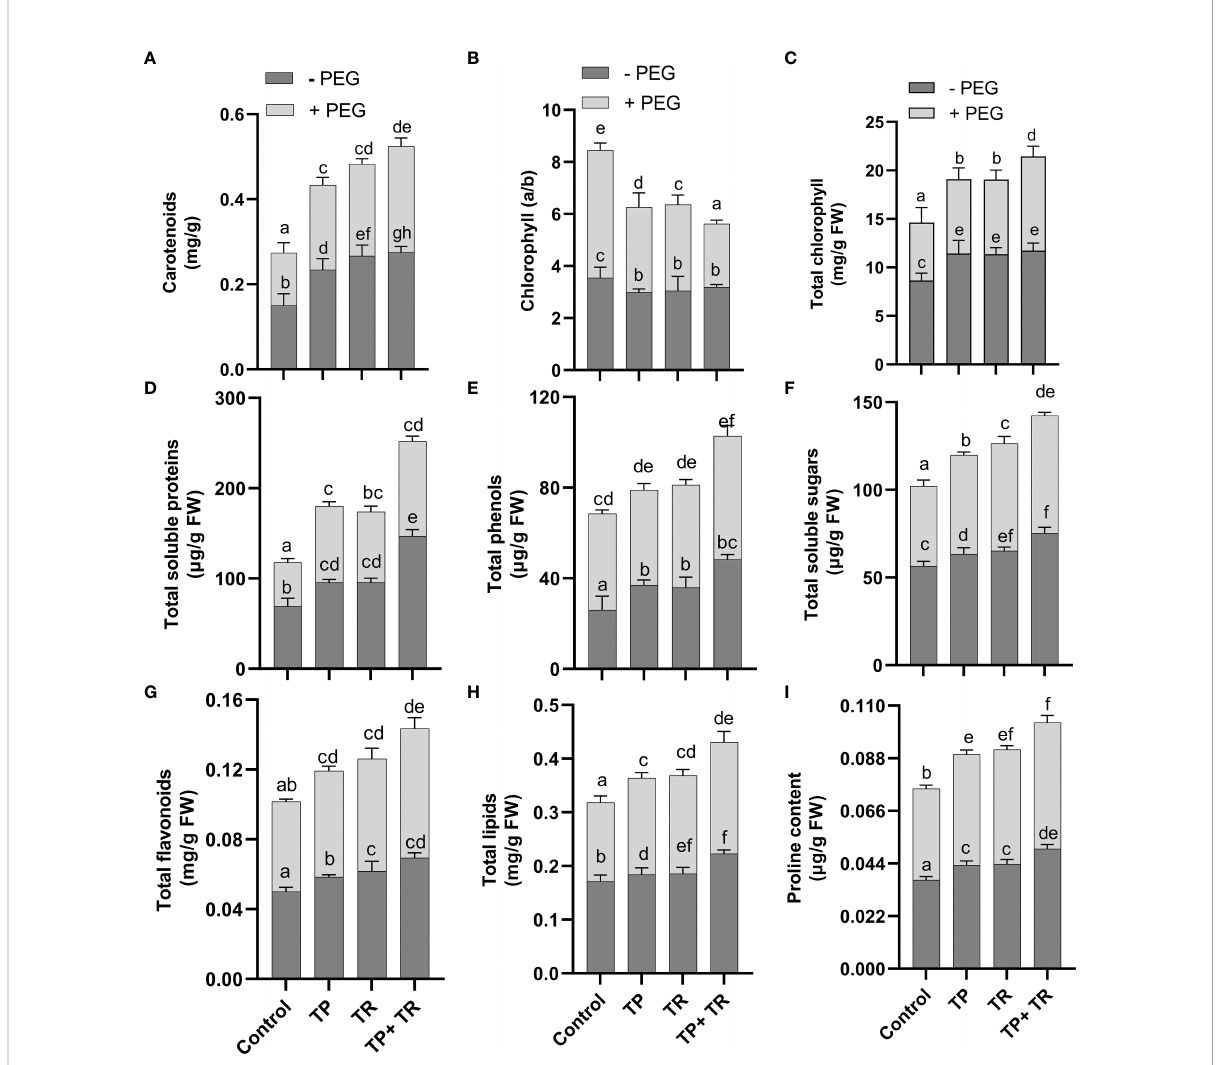
FIGURE 6 Effect of TP and TR inoculation on M. oleifera growth promoting metabolites. (A) Carotenoids, (B) Chlorophyll a/b ratio, (C) Total chlorophyll content, (D) Total soluble proteins, (E) Total phenols, (F) Total soluble sugars, (G) Total fl avonoids, (H) Total lipids, and (I) Proline content. Quantitative data is representing the means ± SE values of at least three independent biological replications. Various letters have been presented to show the statistical differences at signi fi cance level of p¾ 0.05 using Duncan ’ s Multiple Range Test